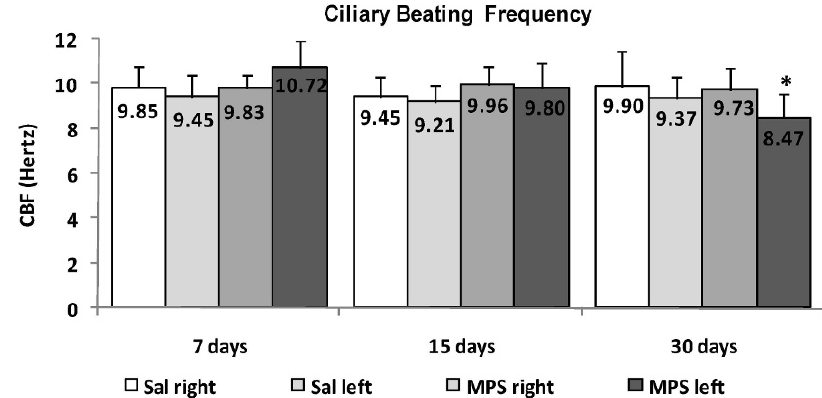
Figure 2 - Ciliary beatfrequency (CBF) of the left (operated) or right (intact) bronchi of rats treated with saline (Sal) or mycophenolate sodium (MPS) for 7, 15, or 30 days. *The MPS left group showed the slowest frequency in 30 days ( p , 0.001 and p= 0.026 vs . 7 and 15 days, respectively; p= 0.003 vs . MPS right at 30